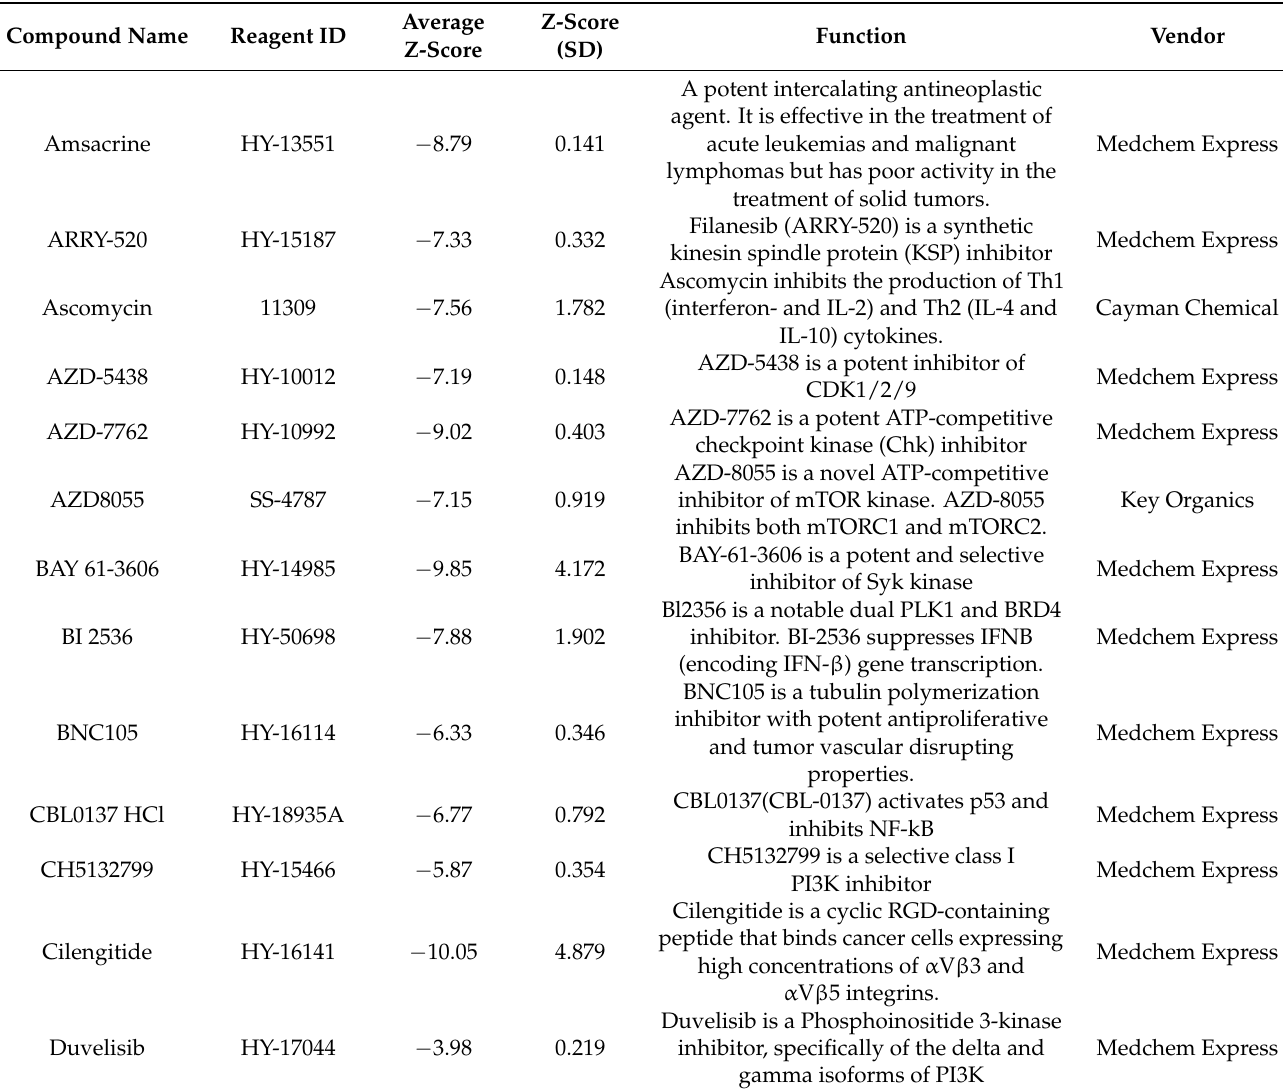
Table 2. List of cherry-picked compounds. The top 50 compounds were selected as positive hits after the primary screen. Average Z-score and standard deviation between the two replicate plates were considered as criteria for selecting these potential hits. The table shows compounds with different mechanisms of action were qualified for cherry-picking, including the proteasomal